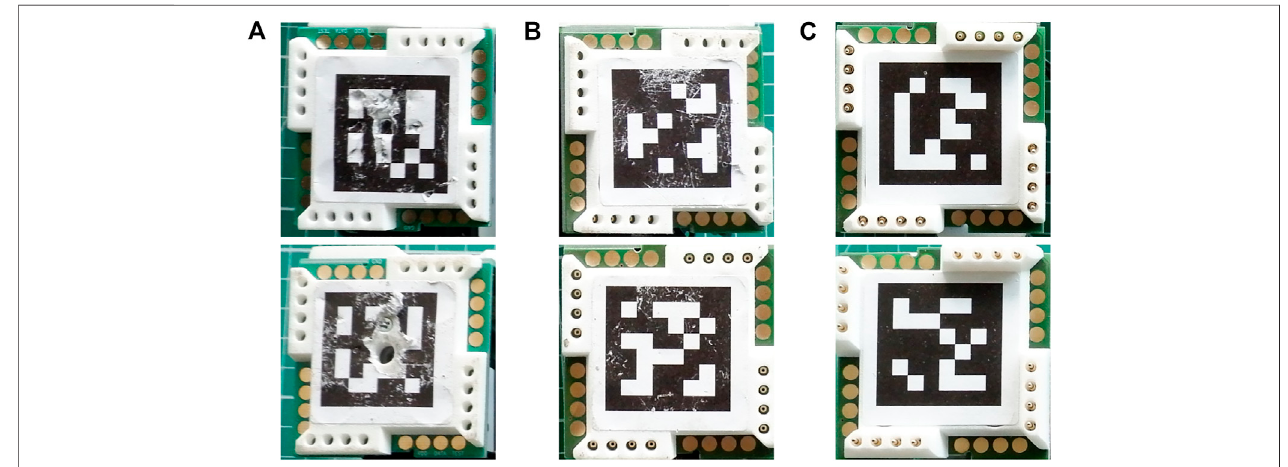
FIGURE 10 | The fi ducial markers after approximately 300 physical evaluations (A) Three pierced tags on female connectors were found (B) Signs of wear on female connectors were found on eight tags (C) There was no wear on all male connectors.